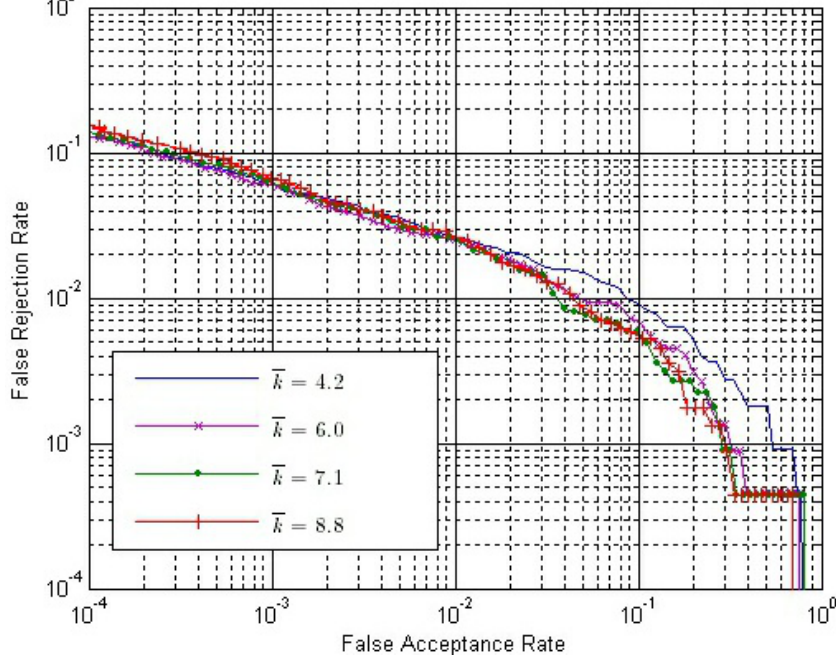
Figure 14. ROC of the final match score with different k values, where both S E and S C are calculated by Strategy IS-2 and S O is calculated by Strategy OS-1.